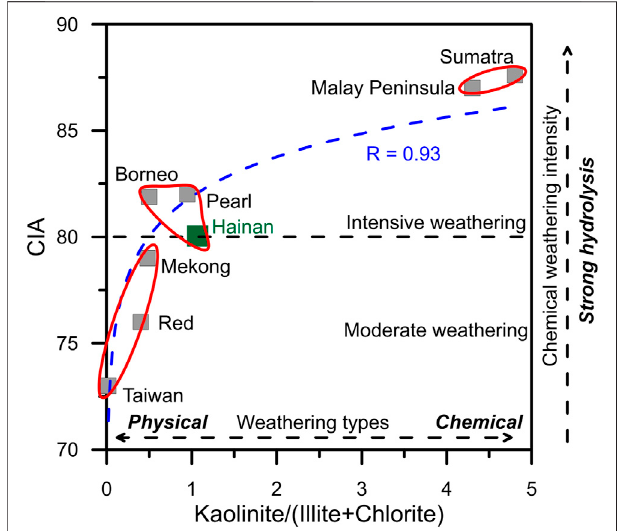
FIGURE 5 | Correlation of CIA with kaolinite/(illite + chlorite) showing the different weathering degrees in the surrounding areas of the SCS. Data of the geochemical elements of Luzon rivers are from the study by Liu et al. (2009), Taiwan rivers from the study by Selvaraj and Chen (2006), the Red, Mekong, and Pearl rivers from the study by Liu et al. (2007), the Malay Peninsula, Sumatra, and Borneo rivers from the study by Liu et al. (2012), and Hainanrivers (this study). Dataof theclay minerals ofthe Luzon rivers arefrom the study by Liu et al. (2009), the Taiwan rivers from the study by Liu et al. (2008), the Red, Mekong, and Pearl rivers from the study by Liu et al. (2007), the Malay Peninsula, Sumatra, and Borneo rivers from the study by Liu et al. (2012), and Hainan rivers from the study by Hu et al.